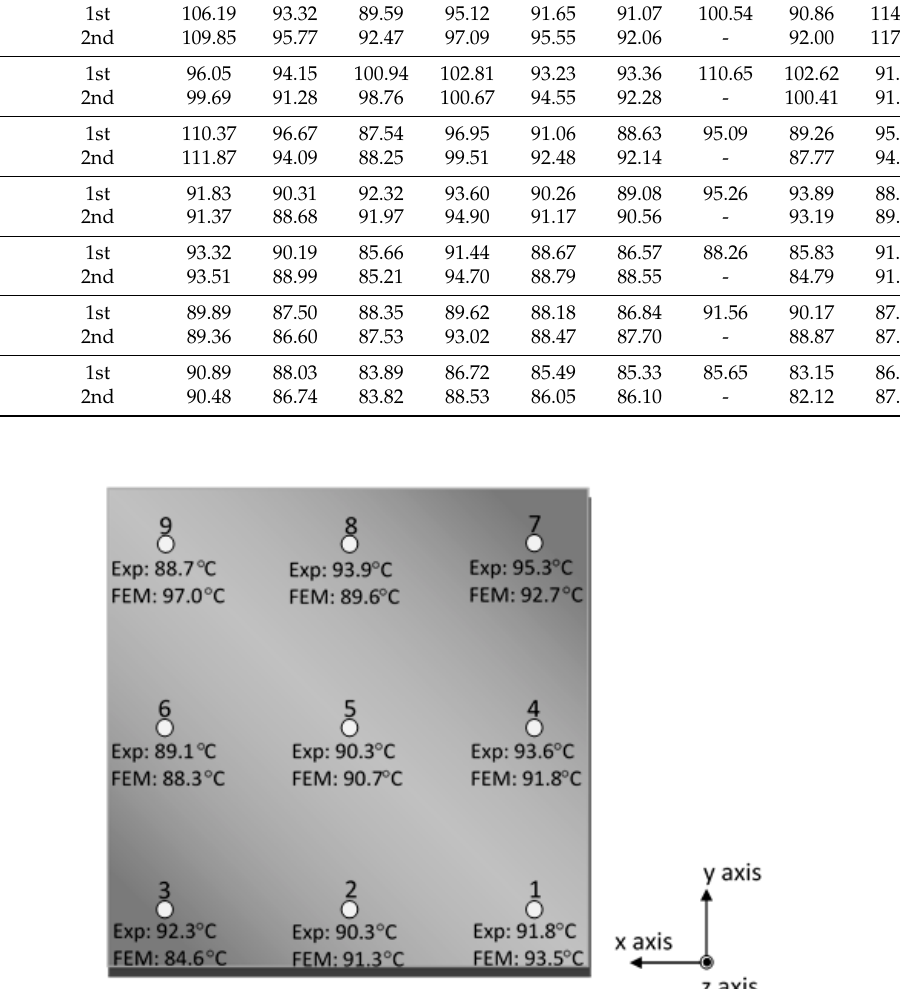
Table 2. Temperature peak values as recorded by two experimental runs for all thermocouple locations. Built Layer